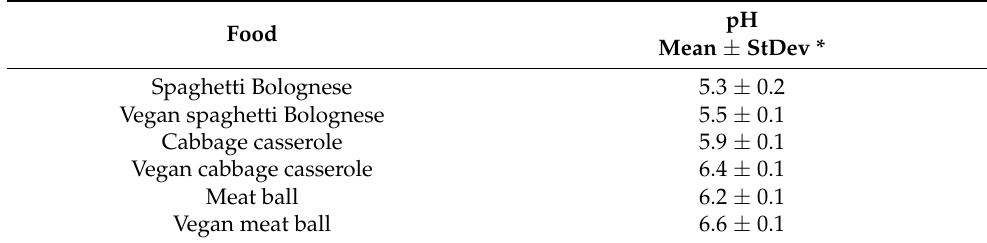
Table 3. The pH values of processed